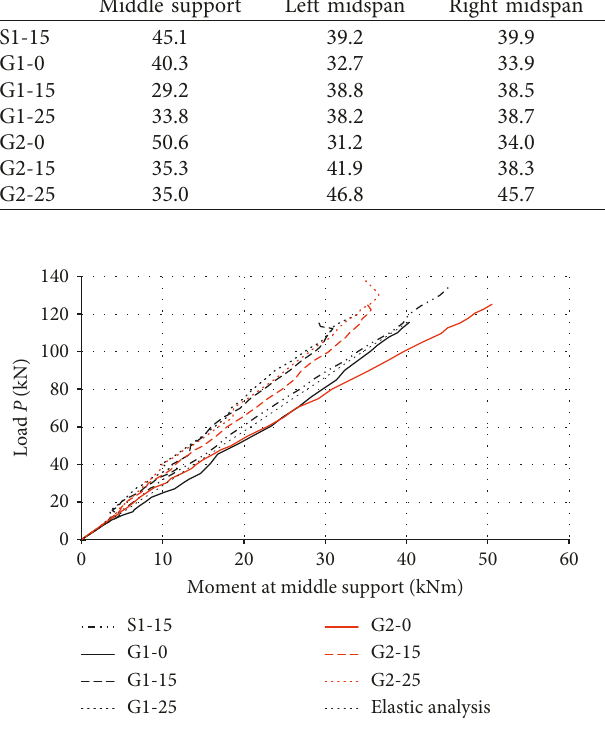
Table 4: Moments at failure, moments based on elastic analysis, and achieved percentage of moment redistribution.